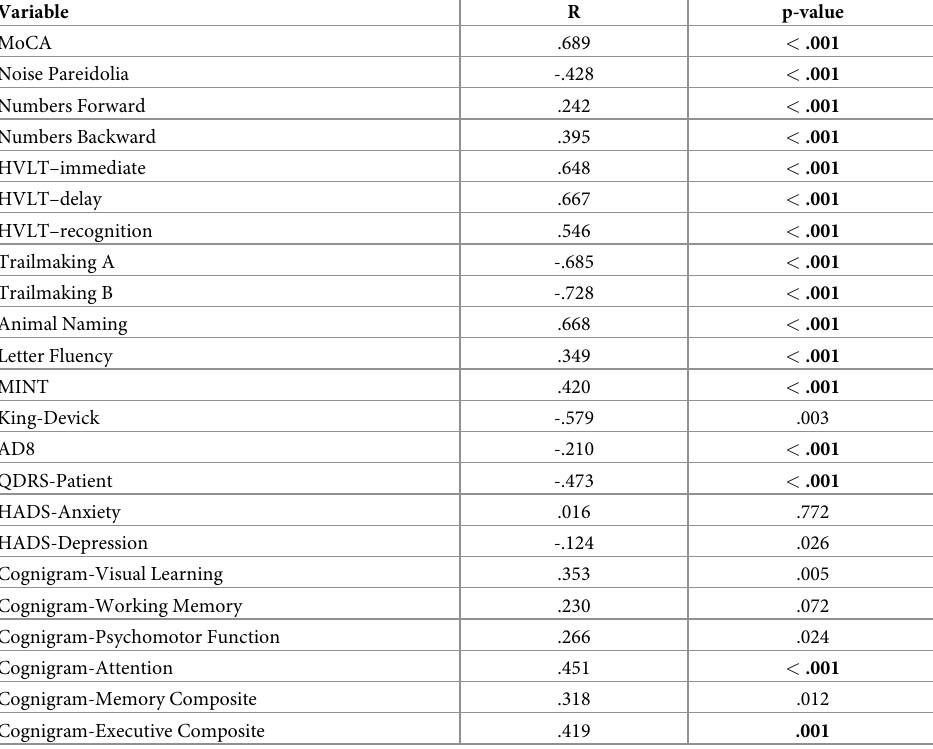
Table 2. Construct validity with neuropsychological measures and patient-reported